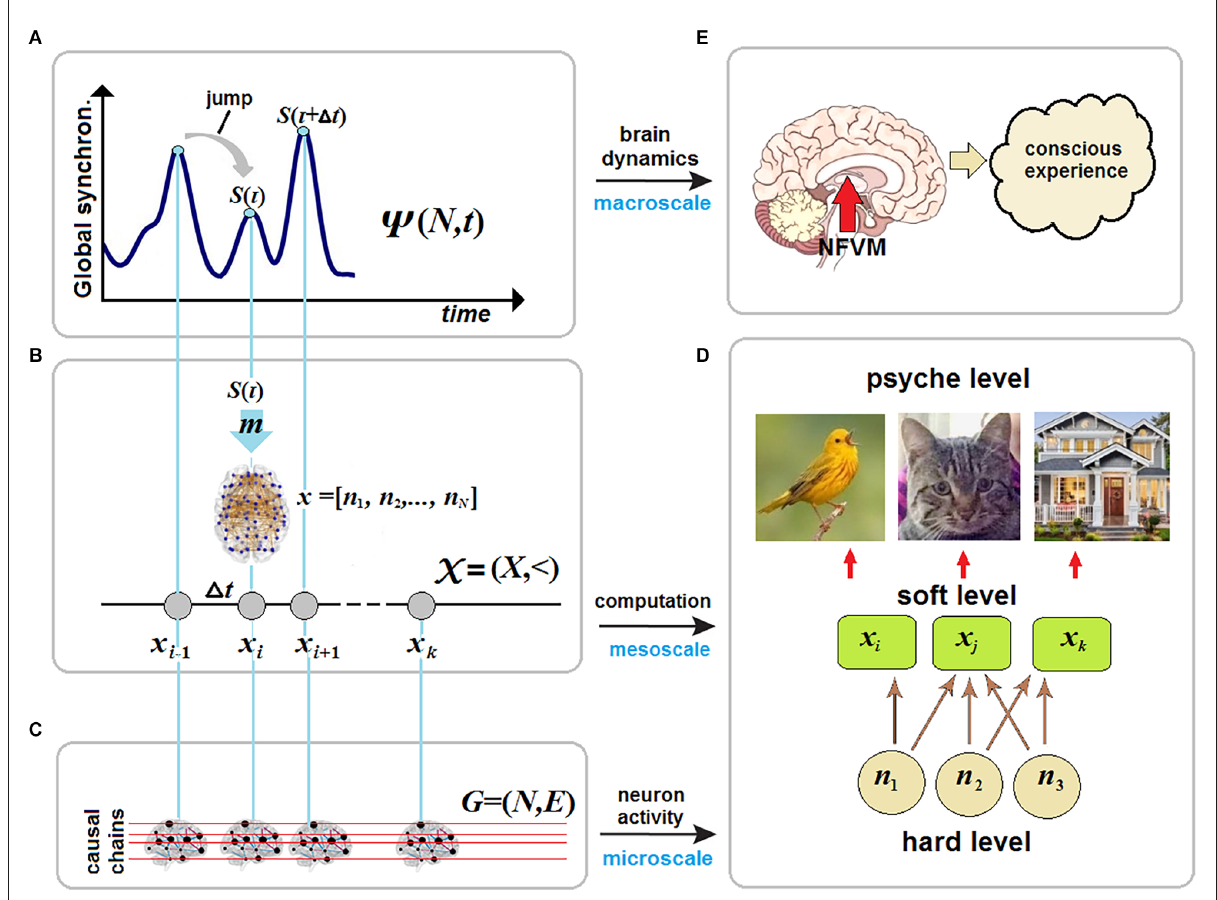
FIGURE1 Brain criticality and conscious experience. (A) In large-scale brain dynamics, conscious states emerge at critical points near phase transitions between synchronization (order) and desynchronization (disorder) patterns of neural activity at the microscale. (B) The map m transforms each critical point of brain dynamics, described in a phase space, onto the whole-brain network N in a vector space as a particular NCC responsible for a certain conscious state at that moment of time. (C) The stream of consciousness can then be formalized as a discrete chain of states ( N - dimensional vectors) and studied in causal dynamical modeling as a directed acyclic graph. (D) In neural pleiotropy, many neurons constitute a particular NCC for producing a certain conscious percept, thereby involving a single neuron in generating very different percepts. (E) Conscious experience is a product of unconscious computations initiated by the brainstem at the hard level and accomplished by various thalamocortical systems at the soft